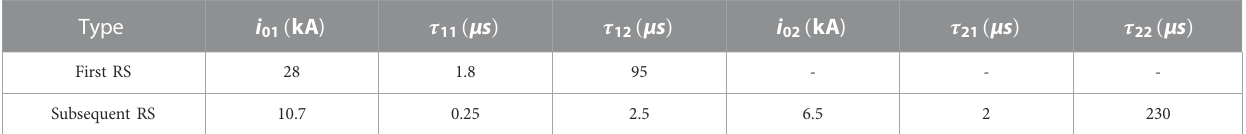
TABLE 1 Typical lightning current waveform parameters of the First RS and Subsequent